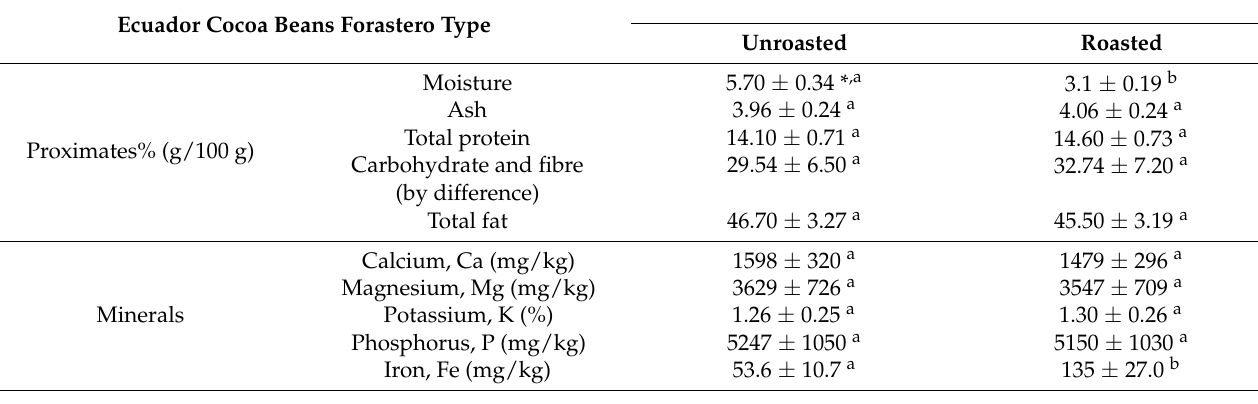
Table 1. The chemical composition of roasted and unroasted cocoa bean samples from Ecuador and Peru. Ecuador Cocoa Beans Forastero